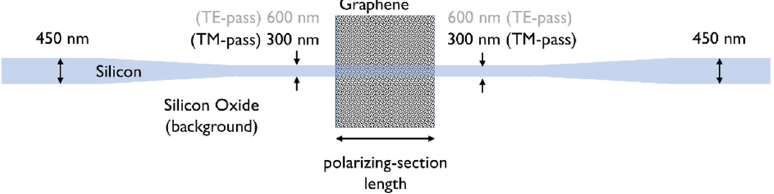
Figure 7. Top view of the graphene-on-silicon waveguide used in the 2D simulations to study polarization